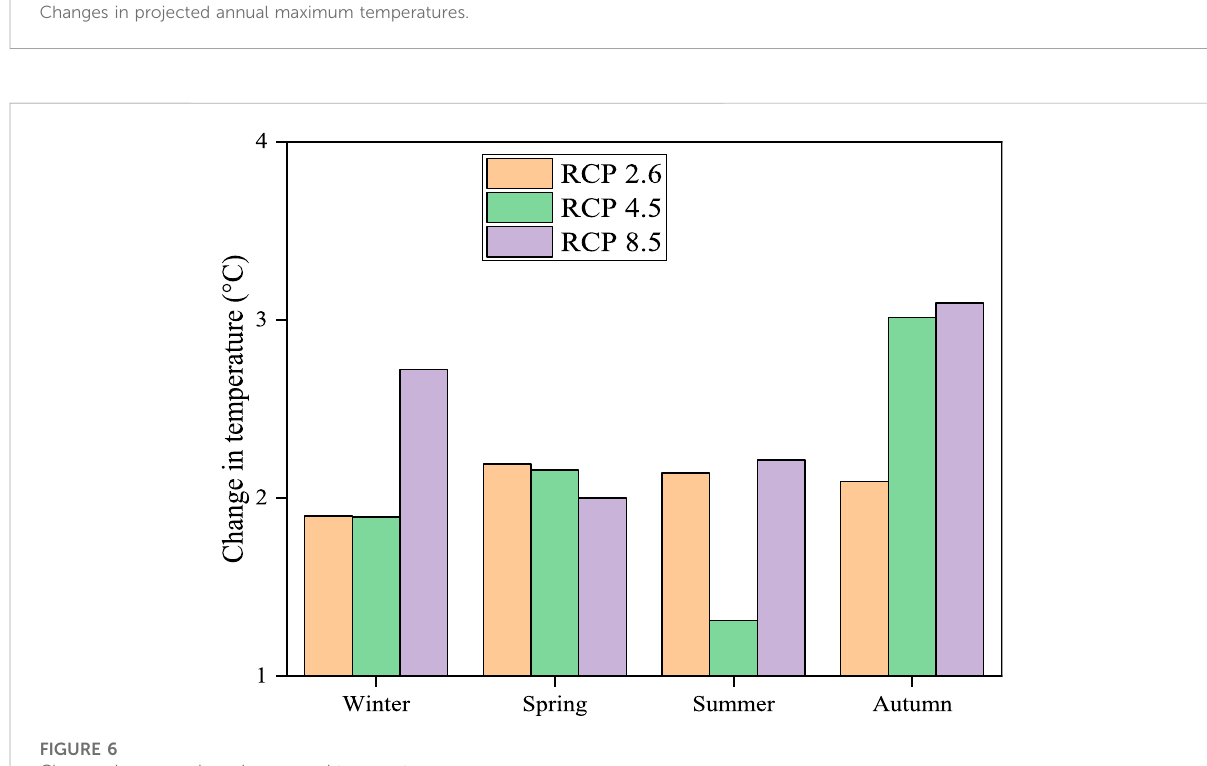
FIGURE 6 Changes in seasonal maximum areal